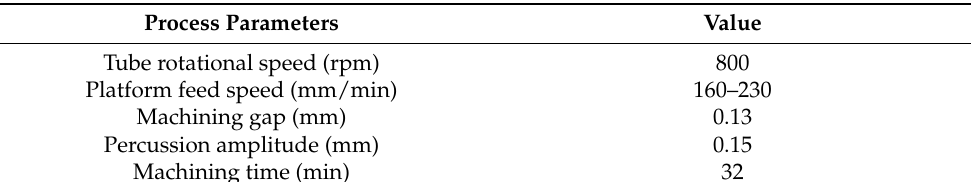
Table 5. Experimental conditions selected for different platform feed speeds.